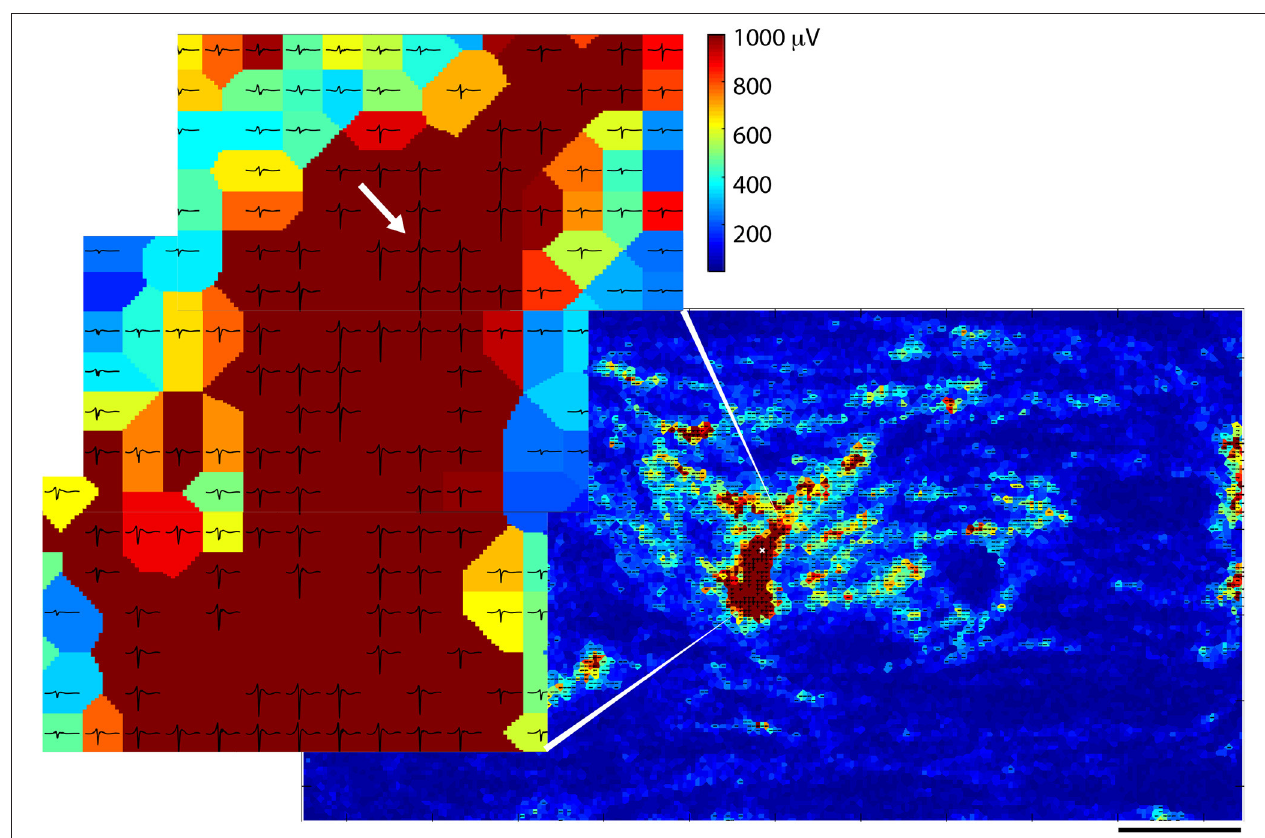
FIGURE 4 | Spike sorting of spontaneous data from one of several spikes observed on a chosen electrode. The heat map shows average spike amplitudes and traces in which spike amplitudes exceeded 300 µ V are overlaid on top of electrodes. The chosen electrode is denoted with a white “x” in the zoomed-out picture, and with a white arrow in the zoomed-in picture. All other electrodes are represented by color according to spike